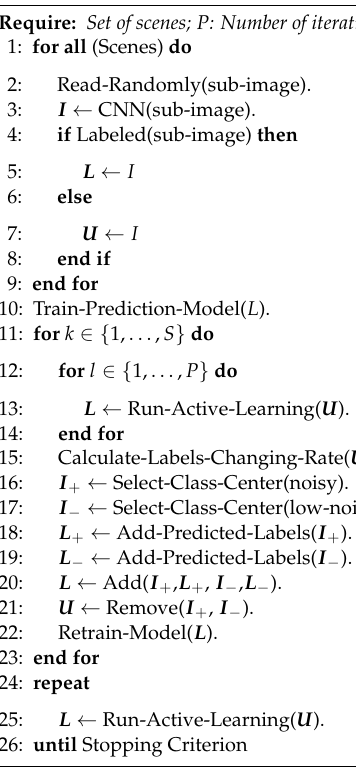
Algorithm 1 Deep active semi-supervised learning